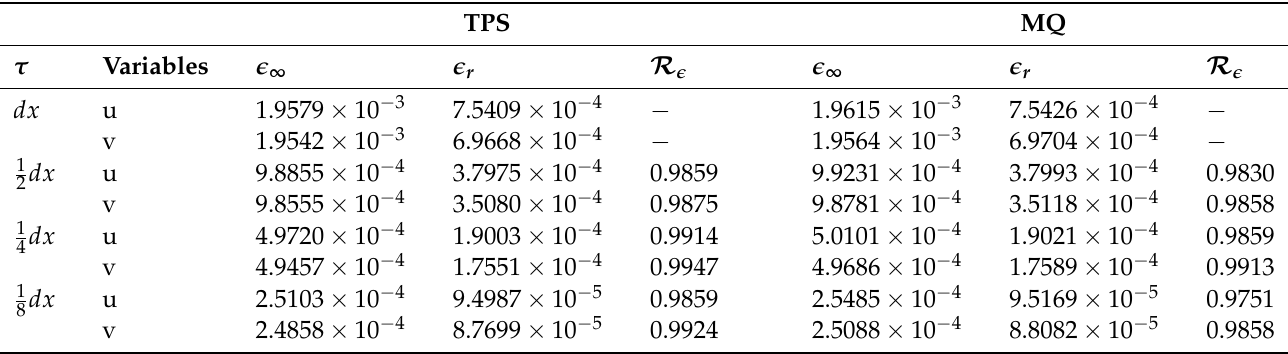
Table 5. Error estimates and CPU times of Example 2 by letting dx = 1 values of τ